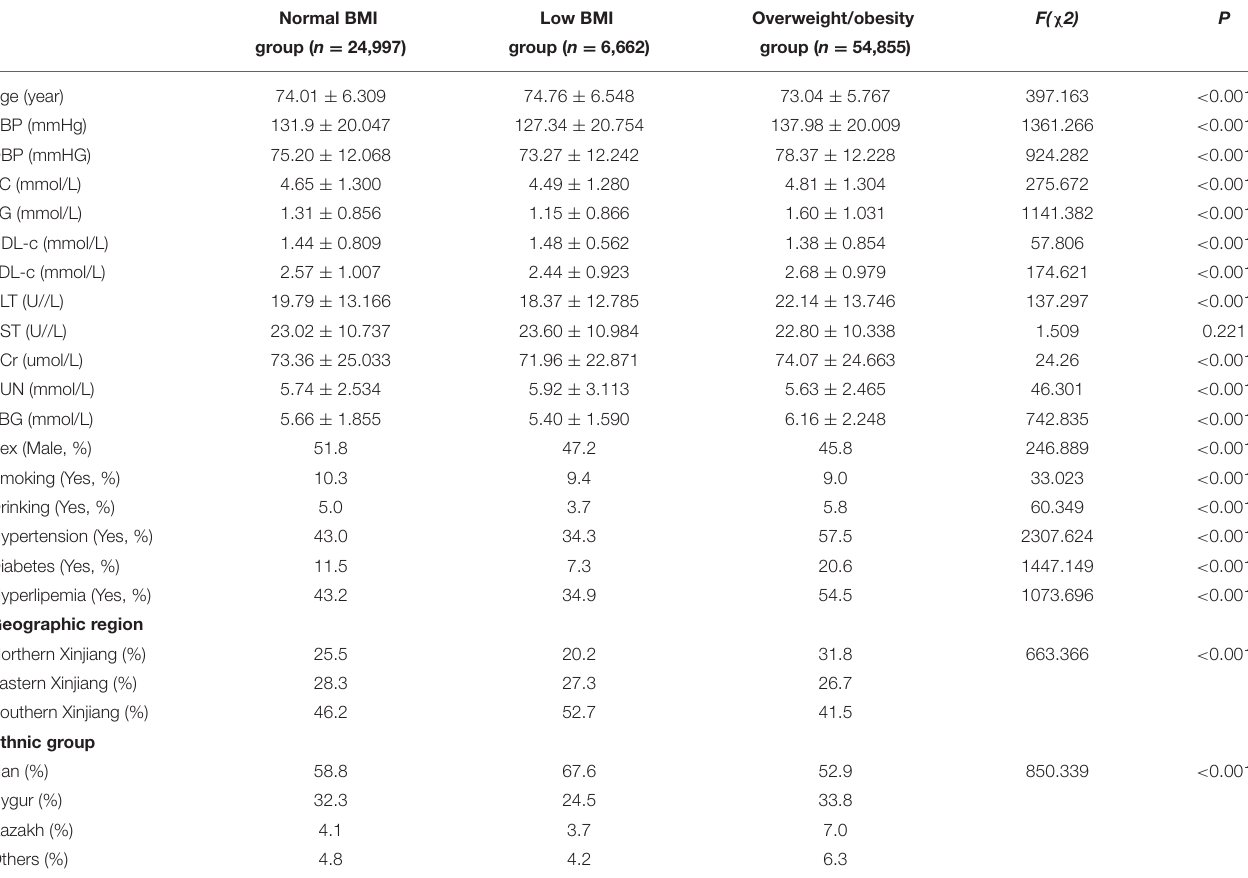
TABLE 1 | Clinical characteristics of the study